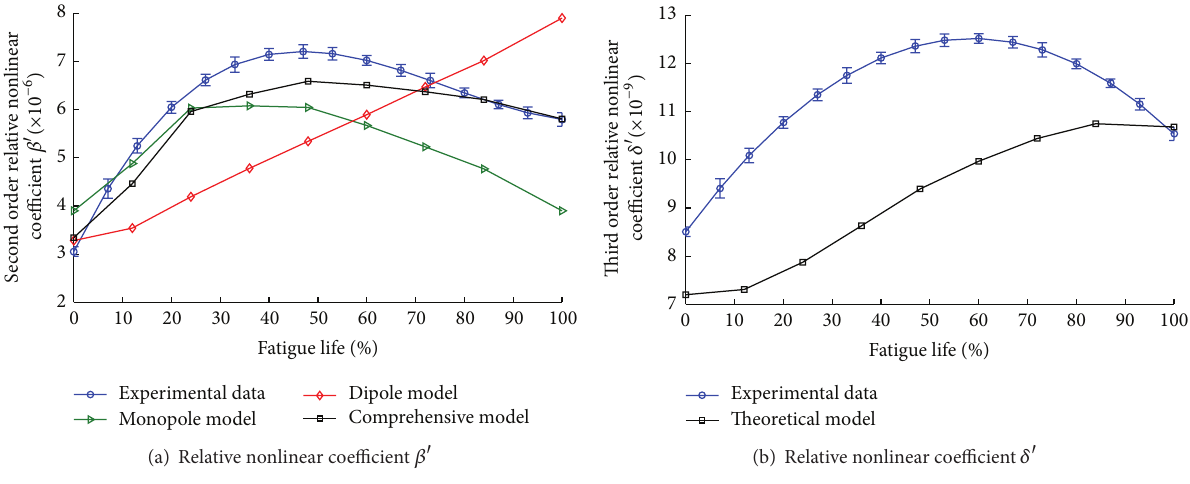
Figure 9: Variation in relative nonlinear coefficient 𝛽 󸀠 and 𝛿 󸀠 as the function of tensile stress.